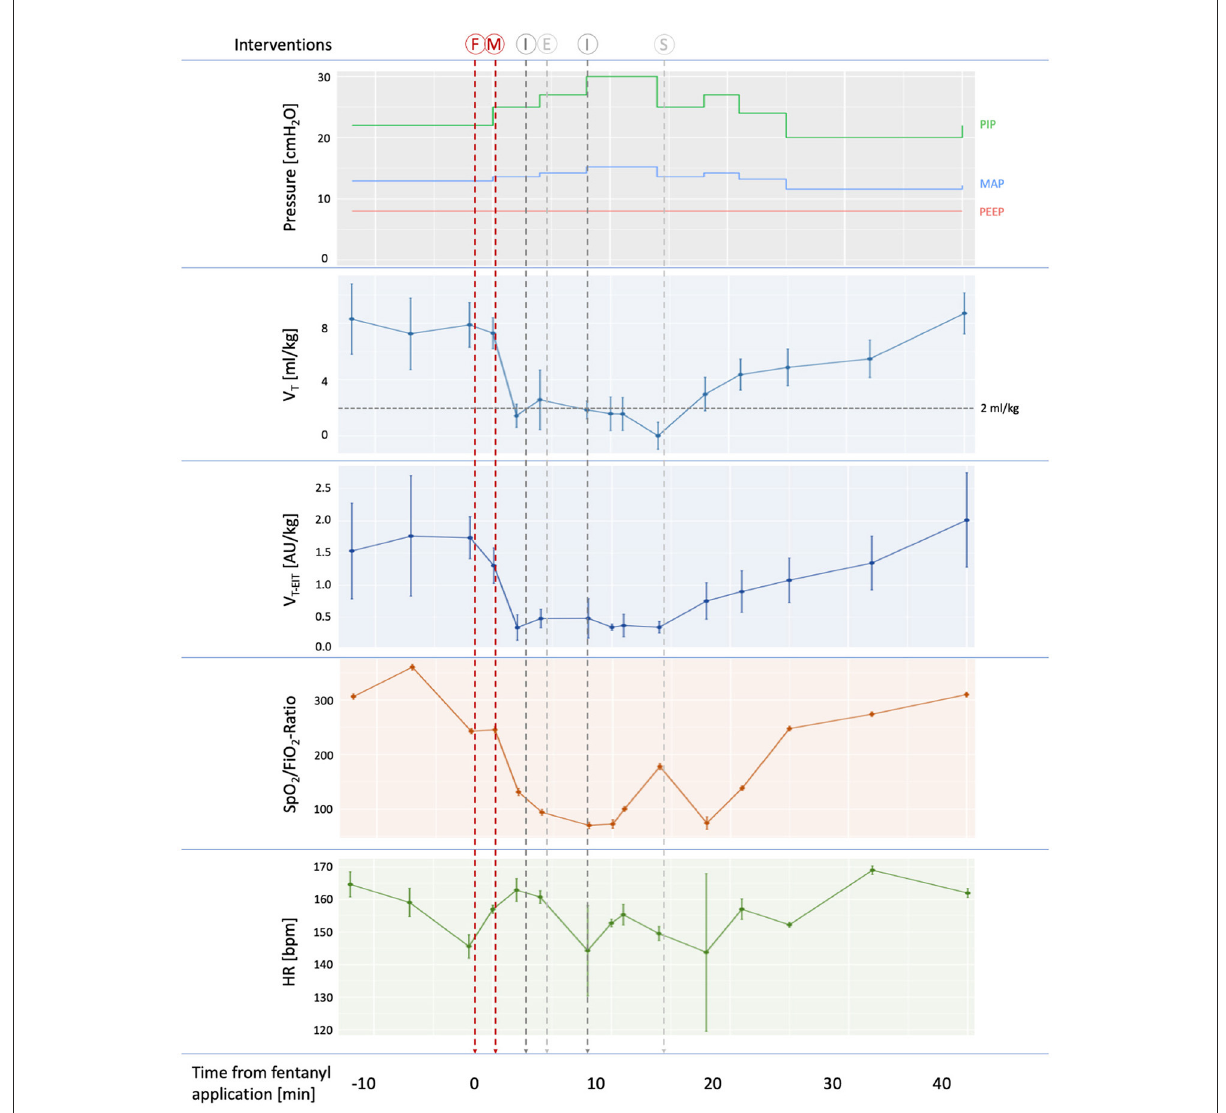
FIGURE1 Development of cardiorespiratory parameters during the intubation procedure. Applied pressures, as well as measured tidal volumes, oxygenation and heart rate are shown. Tidal volumes were measured in the ventilator circuit using a flow sensor at the proximal end of the endotracheal tube ( V T ) and intrapulmonary V T were measured using electrical impedance tomography ( V T − EIT ). Mean values and 95% confidence intervals of ten-second intervals for each time point are shown. Insufficient ventilation ( V T < 2ml/kg) is indicated by a dotted horizontal line. Timing is provided in minutes relative to fentanyl application. Vertical lines indicate interventions performed: F, fentanyl administration; M, mivacurium administration; I, intubation; E, extubation; S, surfactant administration. PIP, peak inspiratory pressure, MAP, mean airway pressure, PEEP, positive end-expiratory